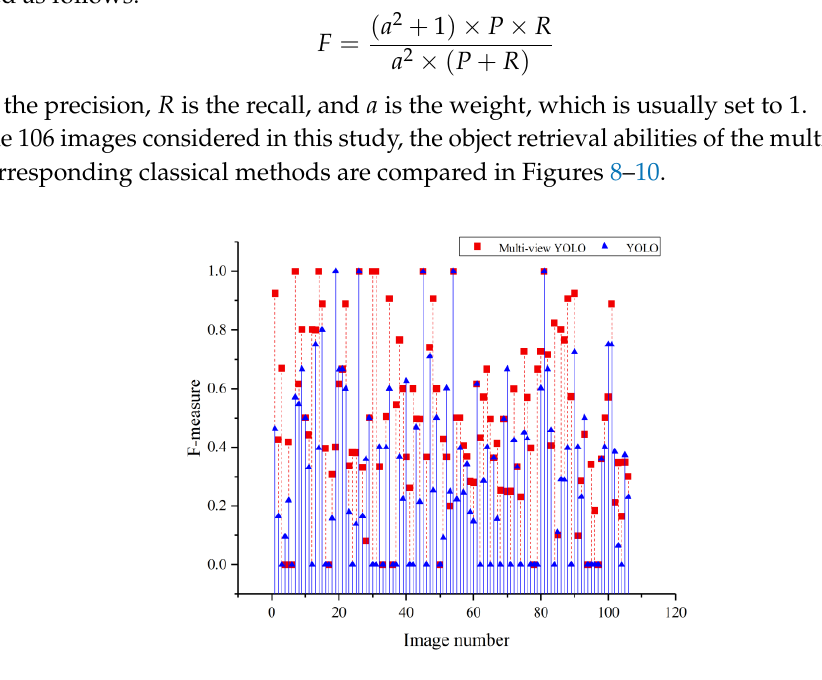
Figure 8. Comparison of the object retrieval abilities of the Multi-view YOLO and classical YOLO methods.